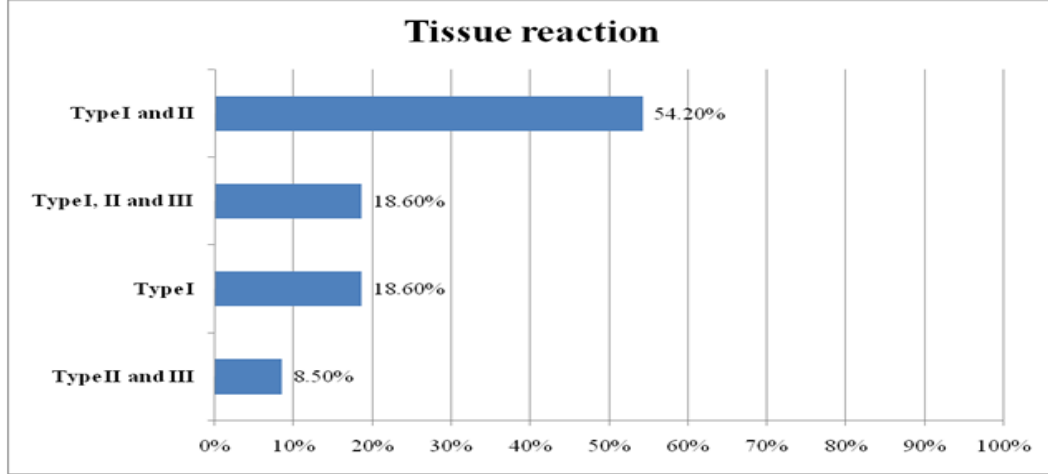
Figure 2. Distribution of study sample according to the host tissue reaction.